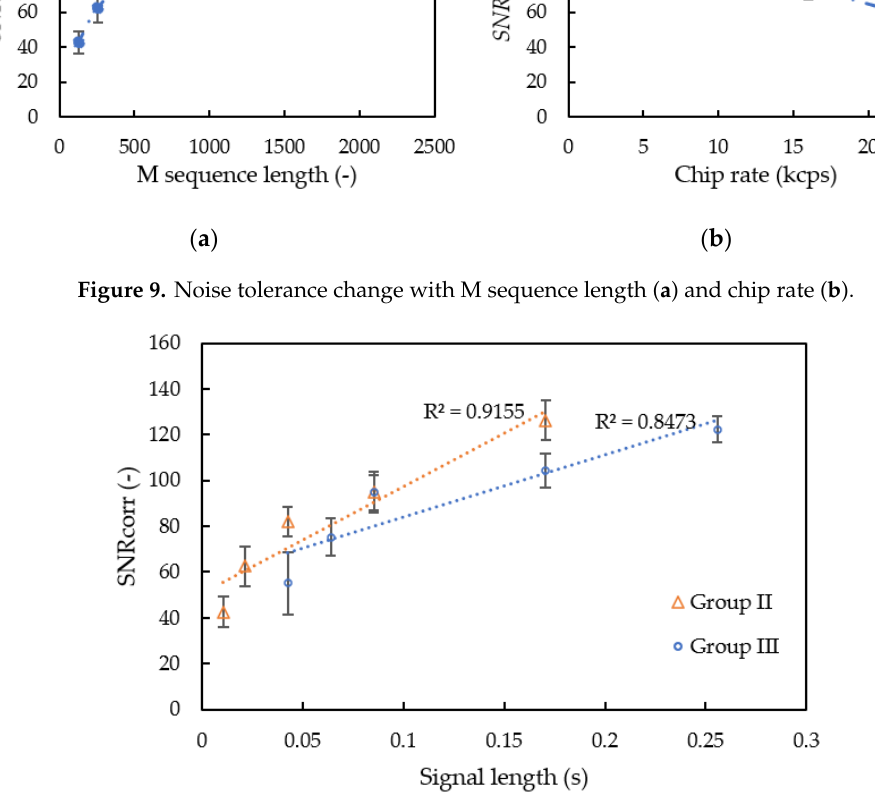
Figure 10. Signal length with the noise tolerance.